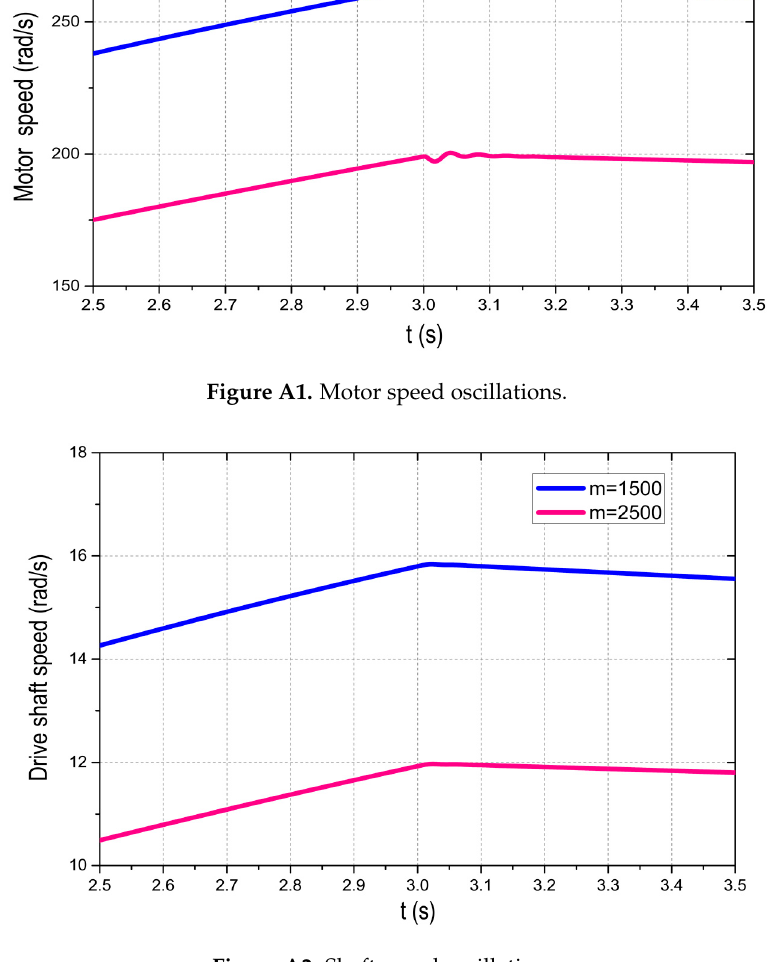
Figure A2. Shaft speed oscillations.